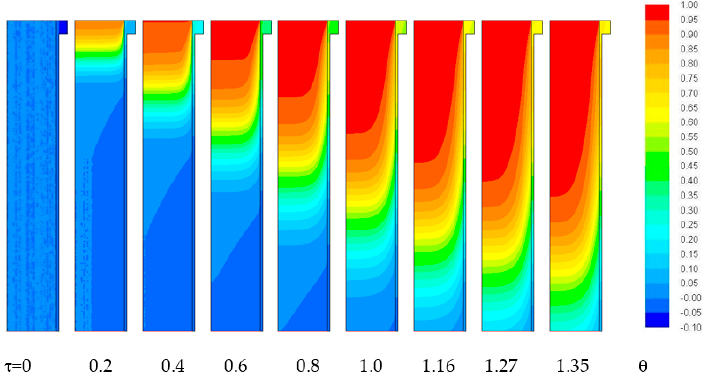
Figure 9. Temperature contour plots of the porous bed at different intervals of the overall time of charge up to θ = 0.3.